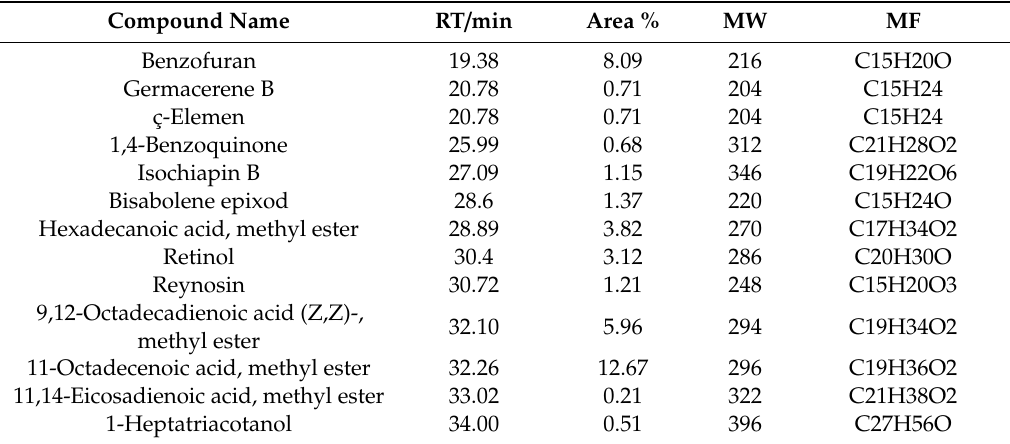
Table 3. Identified compounds from Commiphora myrrha resin